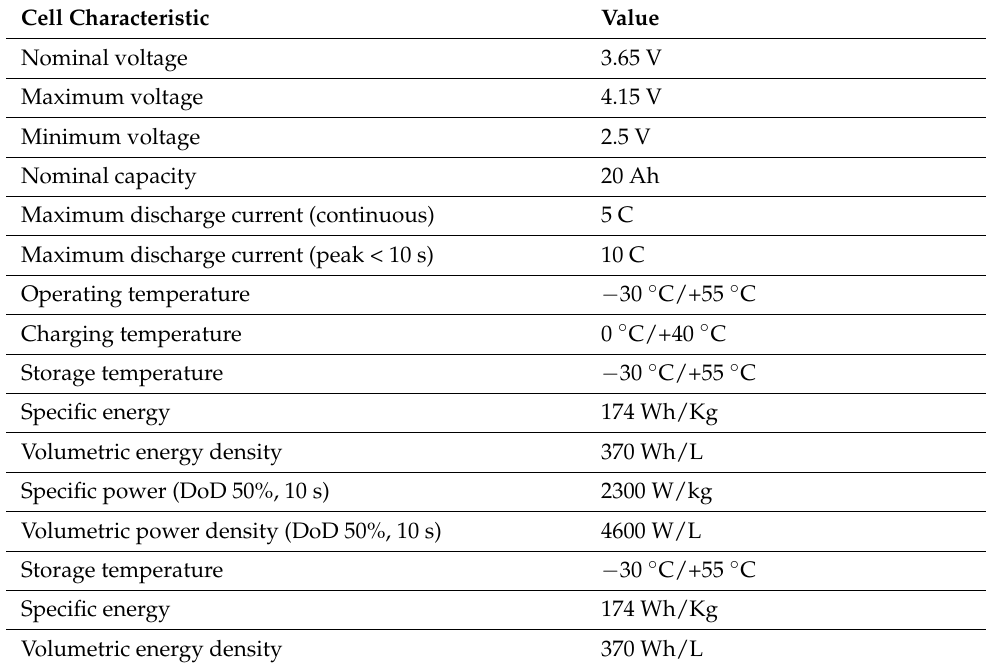
Table 1. Main electric and operating characteristic of EiG PLB C020 cells.